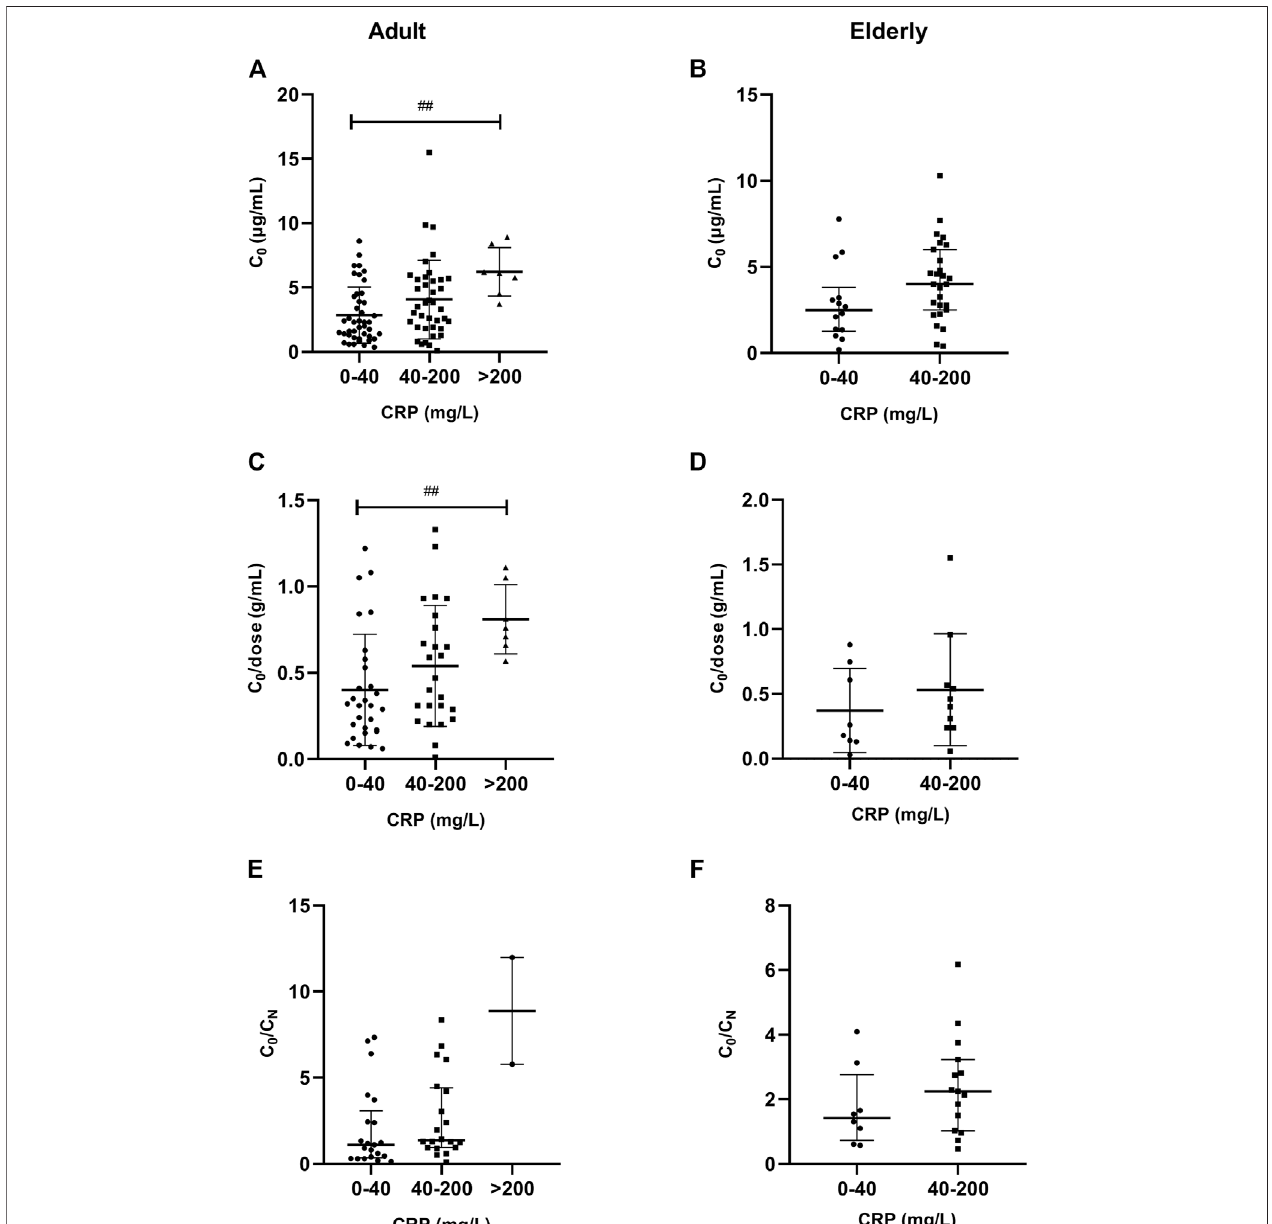
FIGURE 3 | Association of CRP plasma levels with VCZ C 0 , C 0 /dose ratio and VCZ C 0 /C N ratio in adult and elderly patients. (A,B) Distribution of VCZ C 0 . (C,D) Distribution of VCZ C 0 /dose ratio. (E,F) Distribution of VCZ C 0 /C N ratio. ## p <